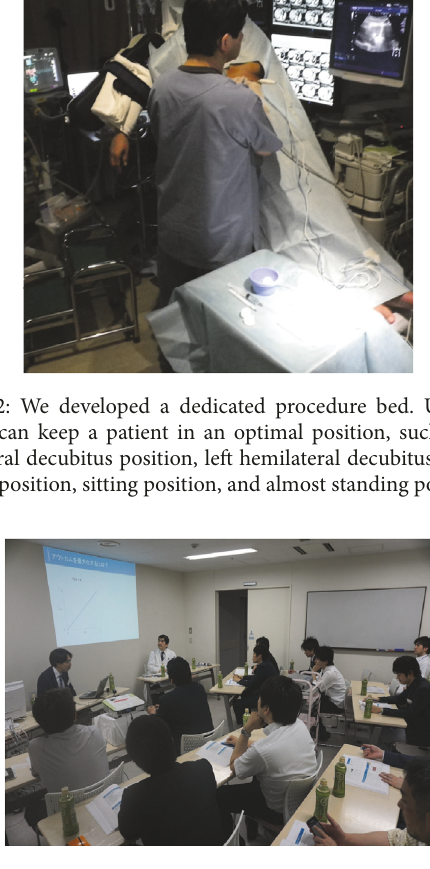
Figure 3: Lecture topics are current status of ablation, ablation systems, ultrasound systems, various techniques in ablation, and